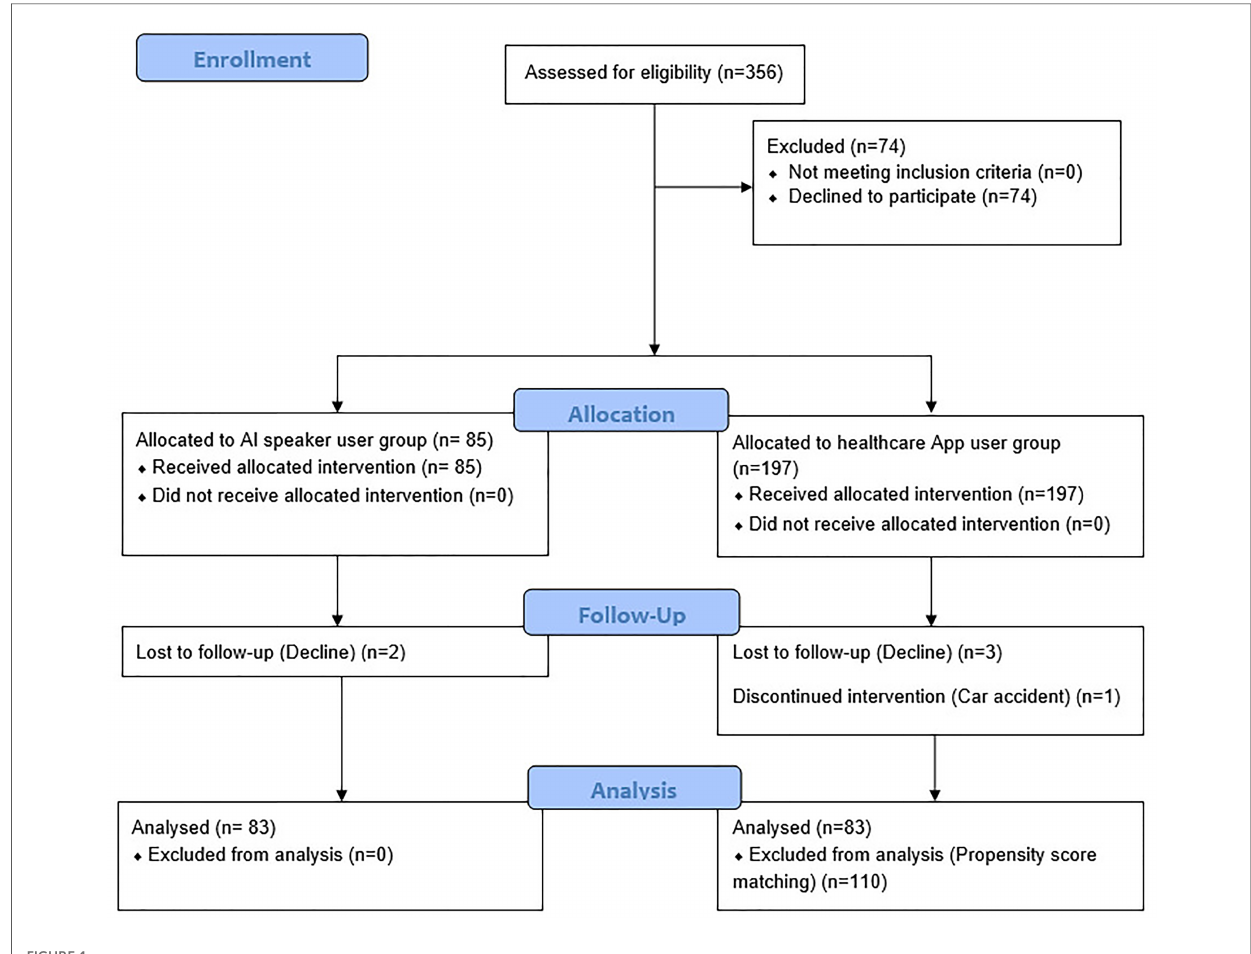
FIGURE 1 CONSORT fl ow diagram of the